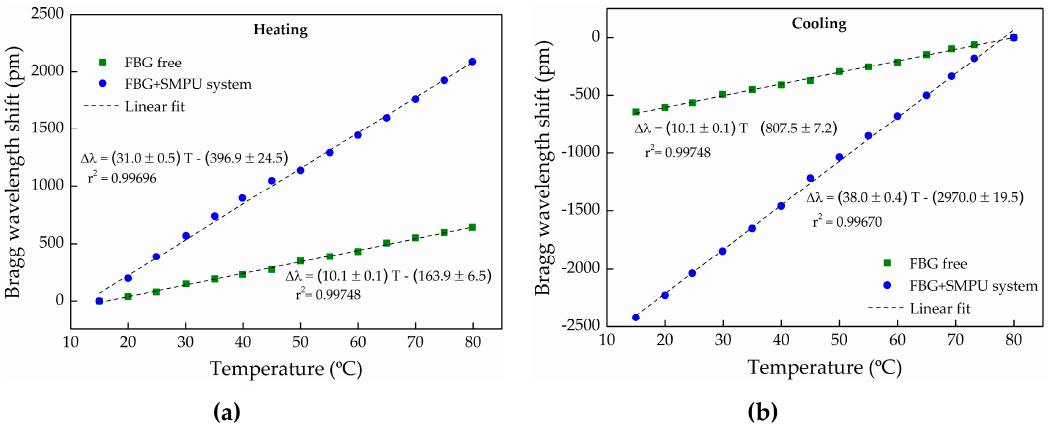
Figure 6. Thermal characterization of the free and the FBG+SMPU system during ( a ) heating and ( b ) cooling.